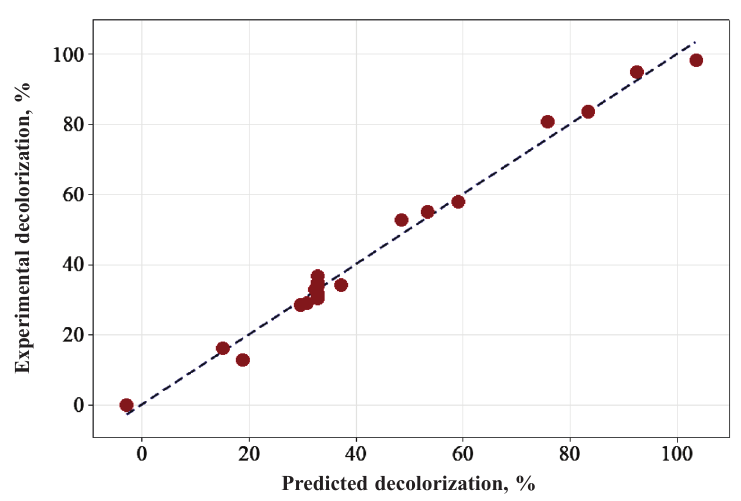
Fig. 7 – Actual (experimental) vs. predicted values for decolorization of Rh 6G